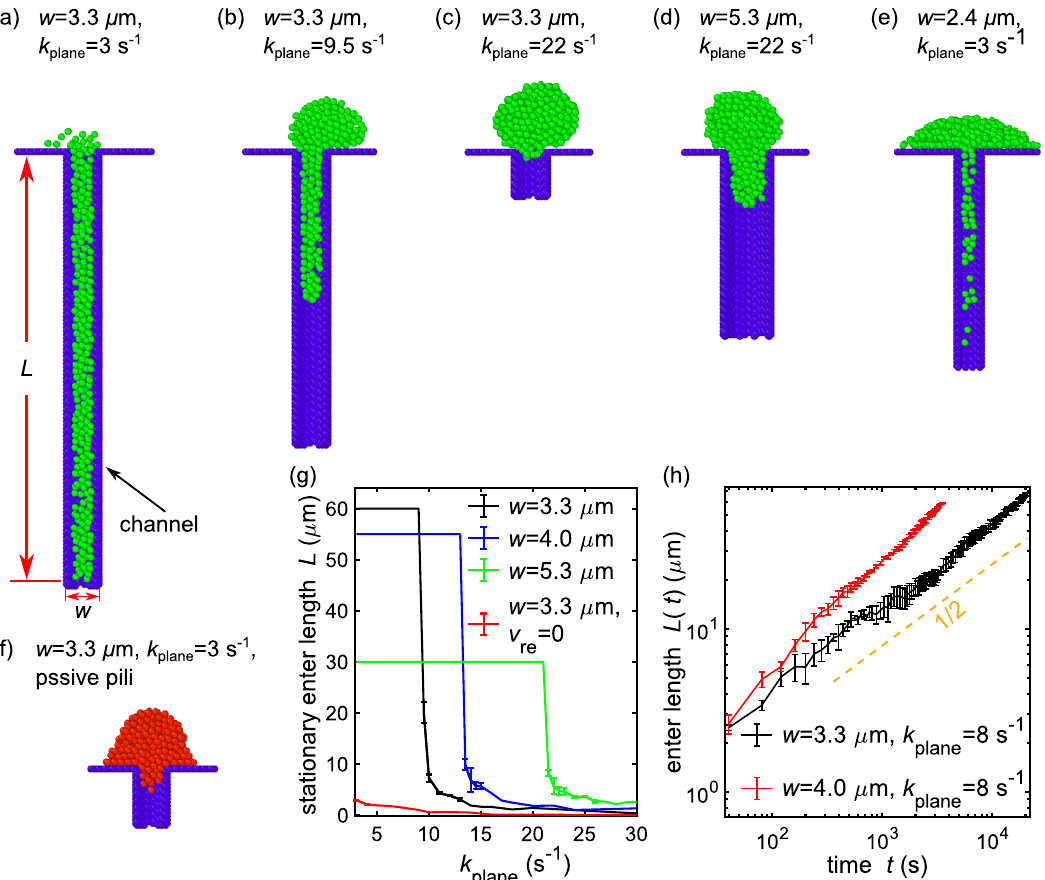
Fig. 7 Colonies atop surfaces containing channels. a – c Simulated wild-type colonies that are initially positioned on top of a narrow channel can invade the channel by making use of pilus activity if the pilus – substrate bonds are strong. The length that a colony enters a channel is denoted by L . d Colonies more easily invade a wider channel. e Invasion of very narrow channels is possible, but colonies break up in this geometry f Passive colonies are not seen to invade channels fully in simulations. g Stationary lengths of colonies after entering channels of different widths. Depending on the channel width, full entrance of the colony occurs below a critical value of k plane . h The time evolution of the enter length is described approximately by a power law. Error bars represent standard deviations from three simulation